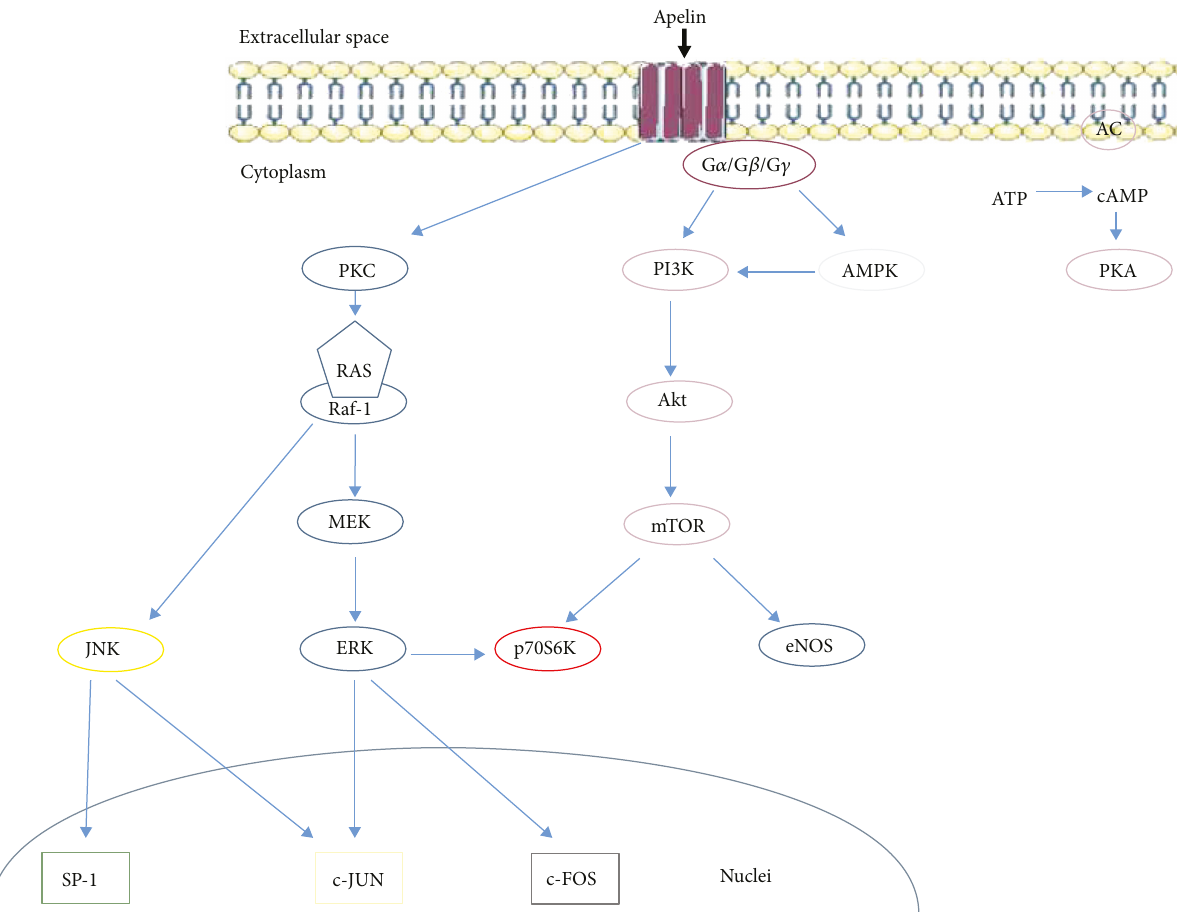
Figure 3: Pathways of apelin signaling after connection with APJ. PKC: protein kinase C: MEK-ERK activator kinase; ERK: extracellular signal-regulated kinase; JNK: c-Jun N-terminal kinases; SP-1: speci fi city protein 1; PI3K: phosphoinositide 3-kinase; Akt: protein kinase B; mTOR: mammalian target of rapamycin kinase; p70S6K: ribosomal S6 kinase; eNOS: endothelial NOS; AMPK: 5 ′ -AMP-activated kinase: AC: adenyl cyclase; PKA: protein kinase A; ATP: adenosine triphosphate; cAMP: cyclic adenosine monophosphate; c-JUN: transcription factor c-JUN; c-FOS: transcription factor